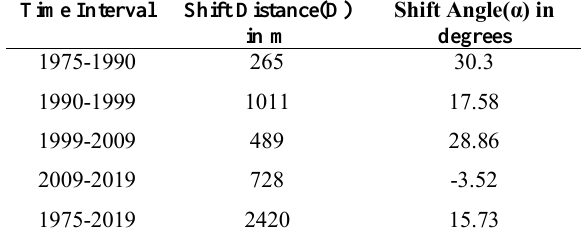
Table 2. Centroid Shift Distance and Angle Apart from displacement, directional understanding of centroid shift plays a vital role in understanding the future evolution direction and possibilities. Vasai's overall shift direction between 1975 to 2019 is NE with an amount of 15.73 degrees. Its evolution has been unidirectional till 2009, i.e., in North East Direction. The angular shift between 2009-2019 shows a change in direction from NE to SE with a minimum of 3.5 degrees. The angular shift between 1975-1990, 1990-1999, and 1999 – 2009 is listed in table 2. Figure 4(I) gives the spatial representation of the built-up centroids, and 4(II) shows the shift trajectory.